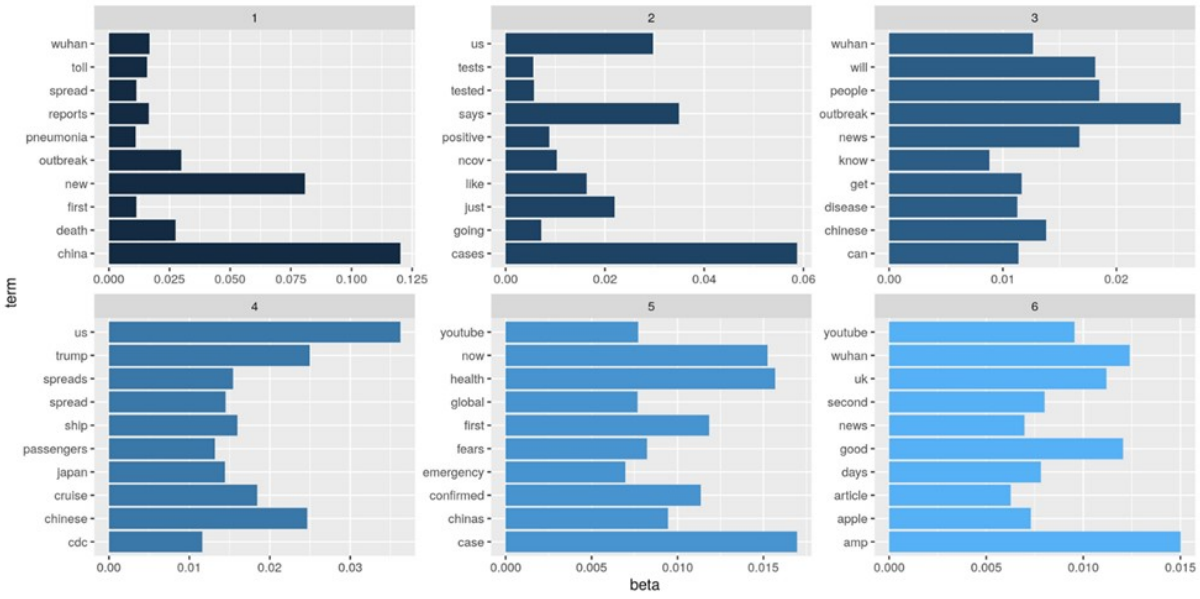
Figure 12. The per-topic-per-word probabilities produced by latent Dirichlet allocation by extracting the beta